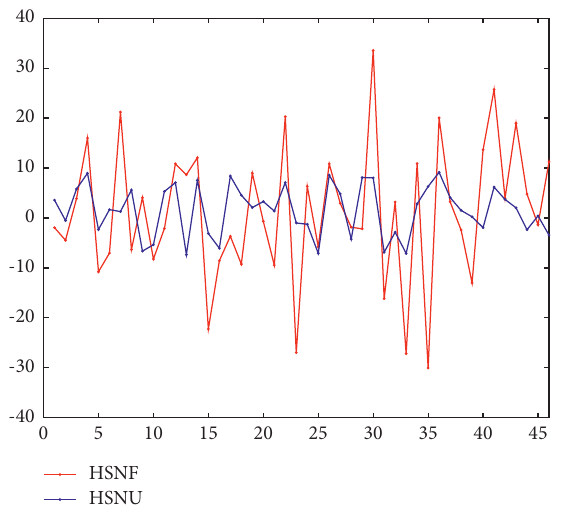
Figure 4: Returns of future 45 days on two financial assets.